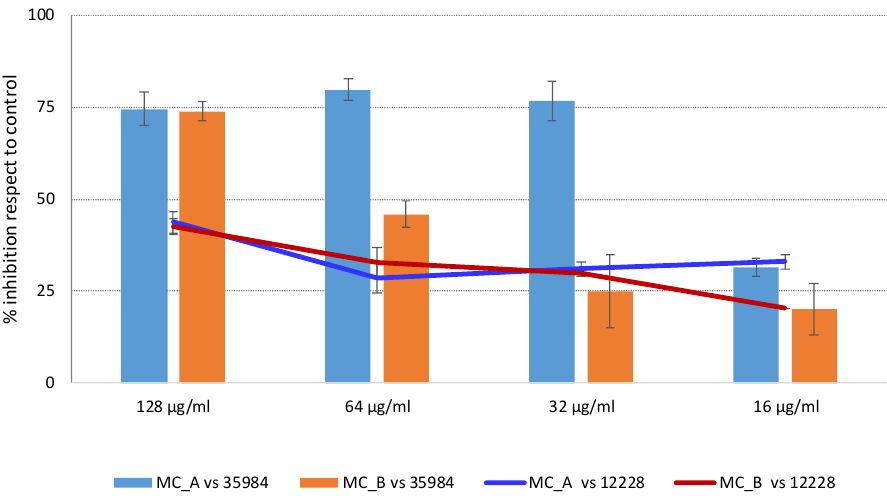
Figure 1. Antimicrobial assay of MC_A and MC_B fractions against S. epidermidis 12228 and 35984 strains. Figure 2. Purification and antimicrobial assessment of MC_A derived fractions (MC_A1, MC_A2, MC_A3) against S. epidermidis and S aureus strains